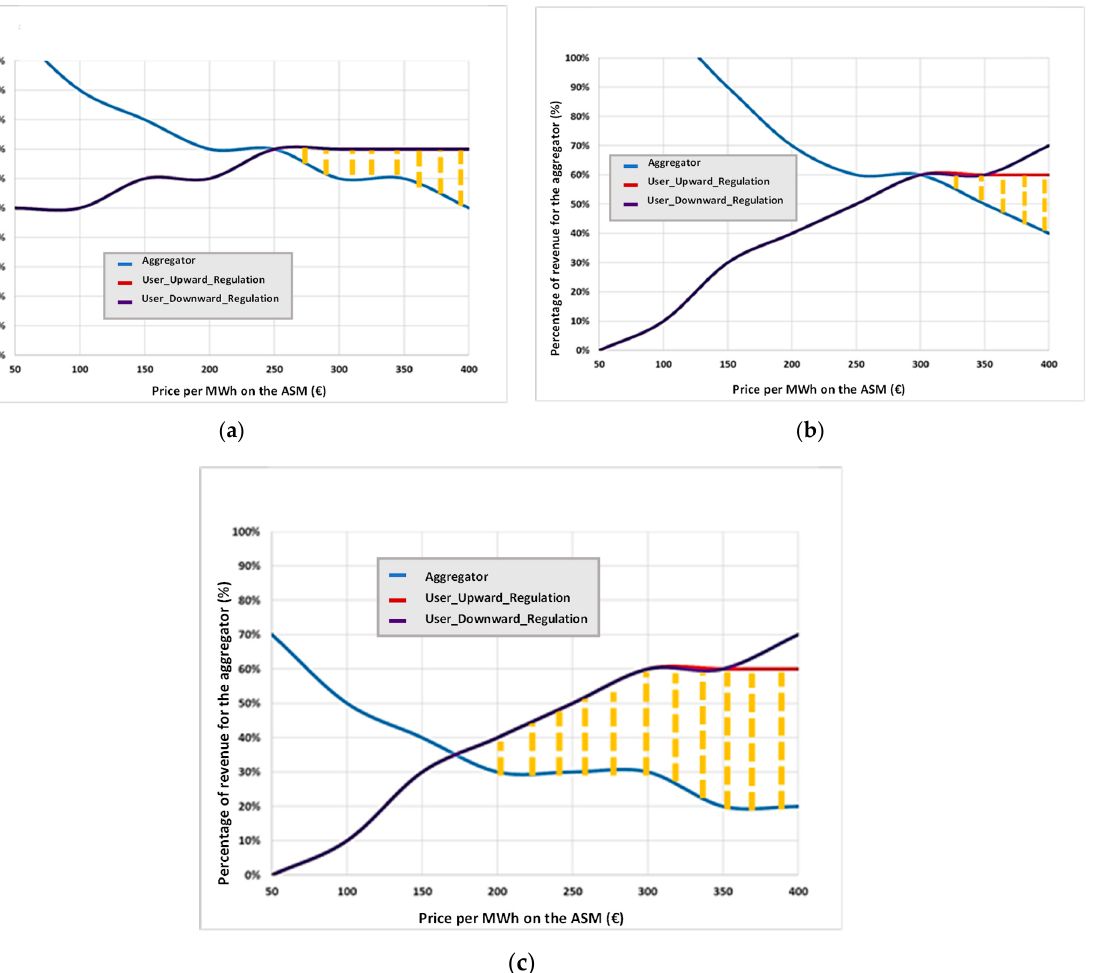
Figure 16. Aggregator-users profit area for ( a ) 2000 MWh of energy exchanged and EMP costs = 0 and COM costs = 50; ( b ) 500 MWh and EMP costs = 0 and COM costs = 50; and ( c ) 2000 MWh, EMP costs = 115 and COM costs = 0.